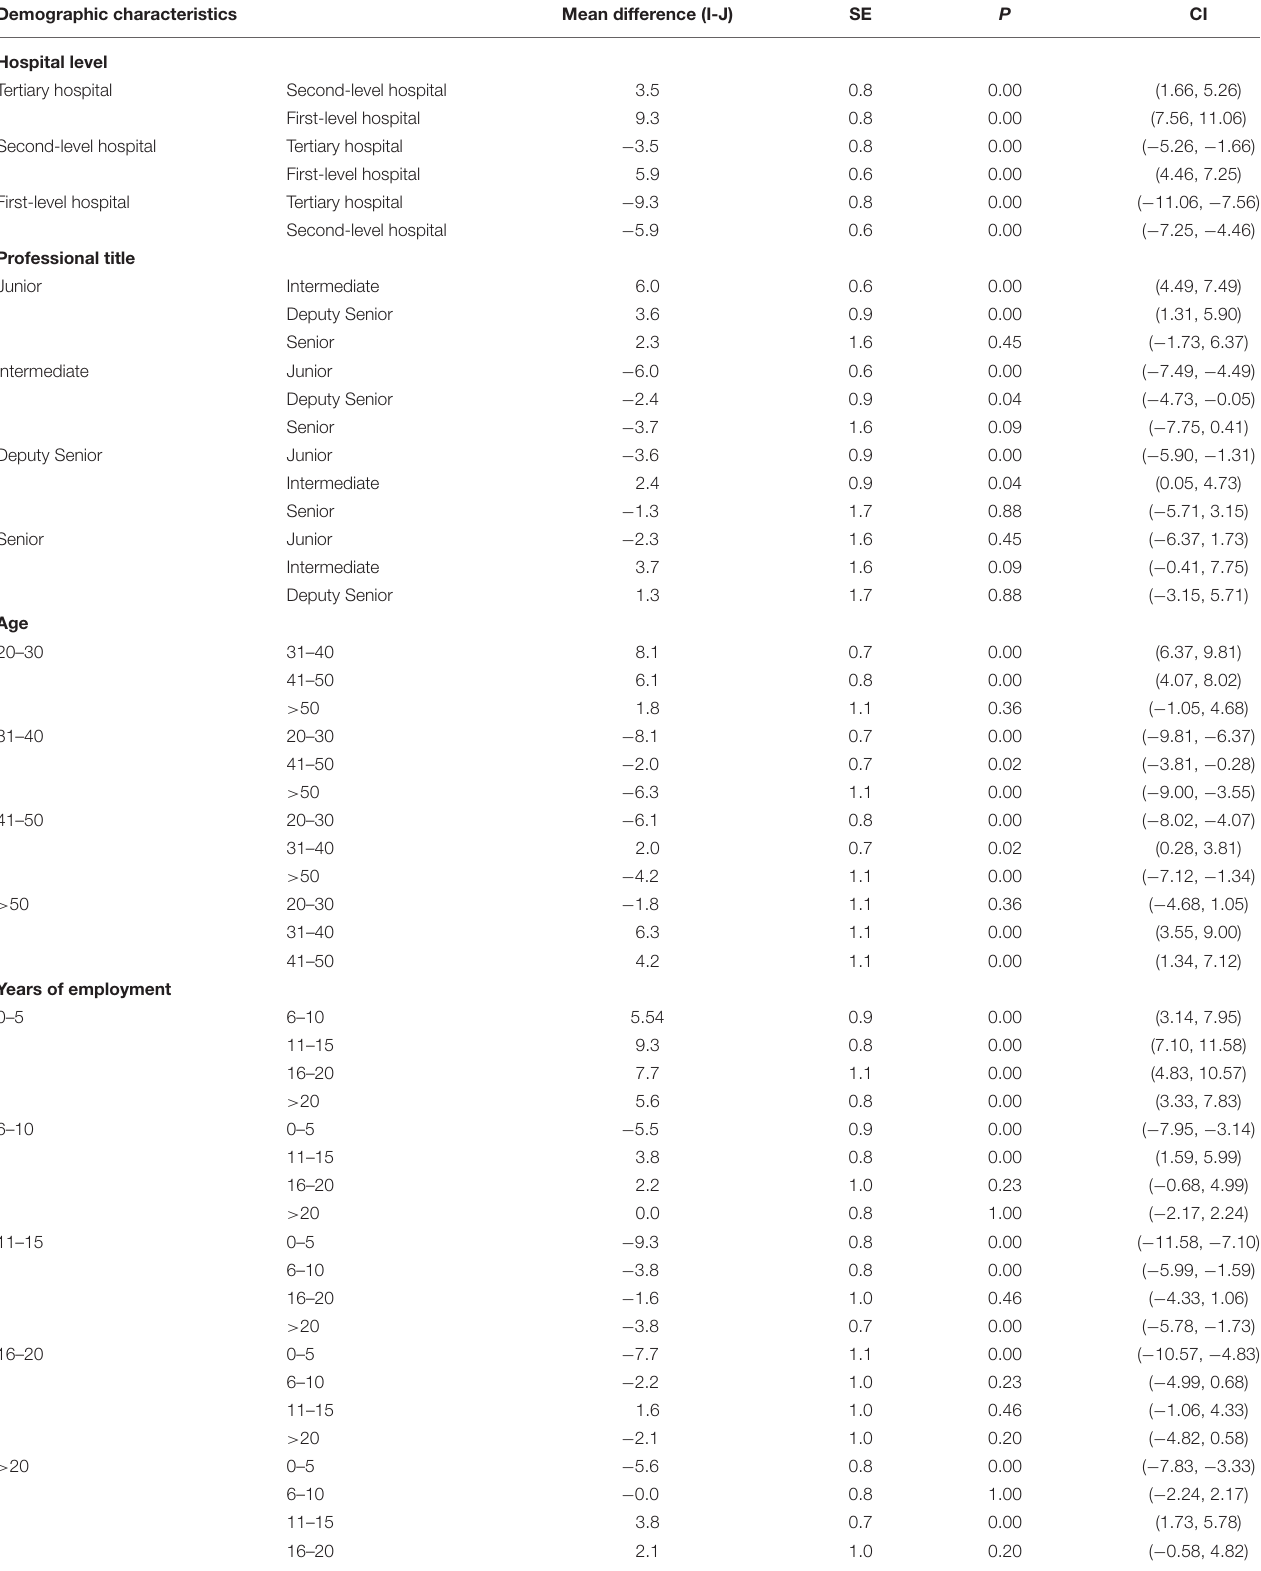
TABLE 2 | Comparison of medical staff in different demographic characteristics actively paying attention to the psycho-social state of patients. Demographic characteristics Mean difference